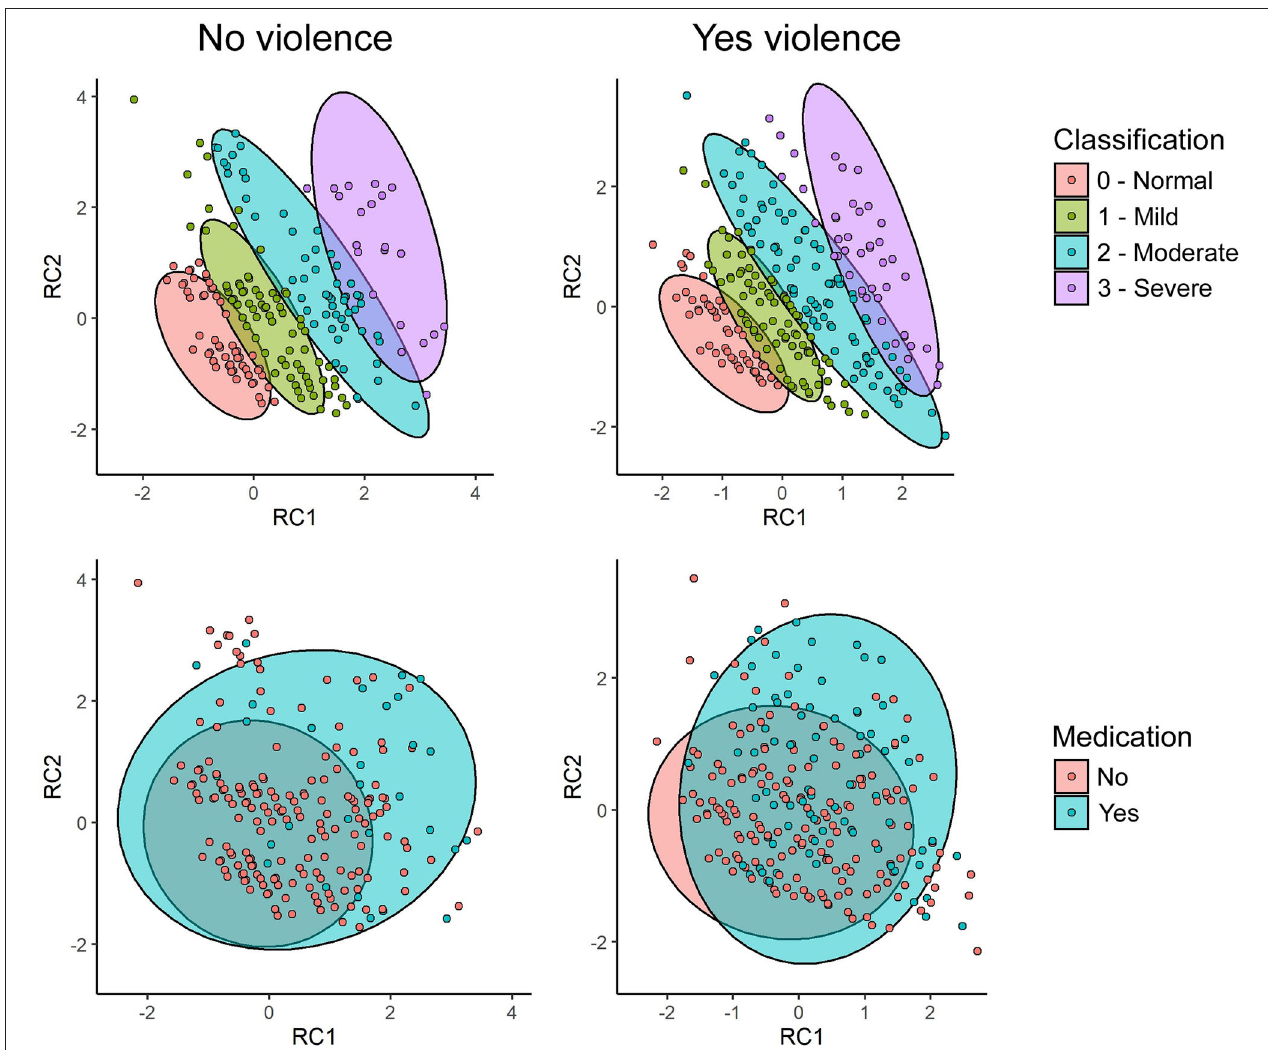
FIGURE 3 | Distribution of the participants’ anxiety scores, and grouping related to severity classification and use of medication between the group that suffered violence and the one that did not.